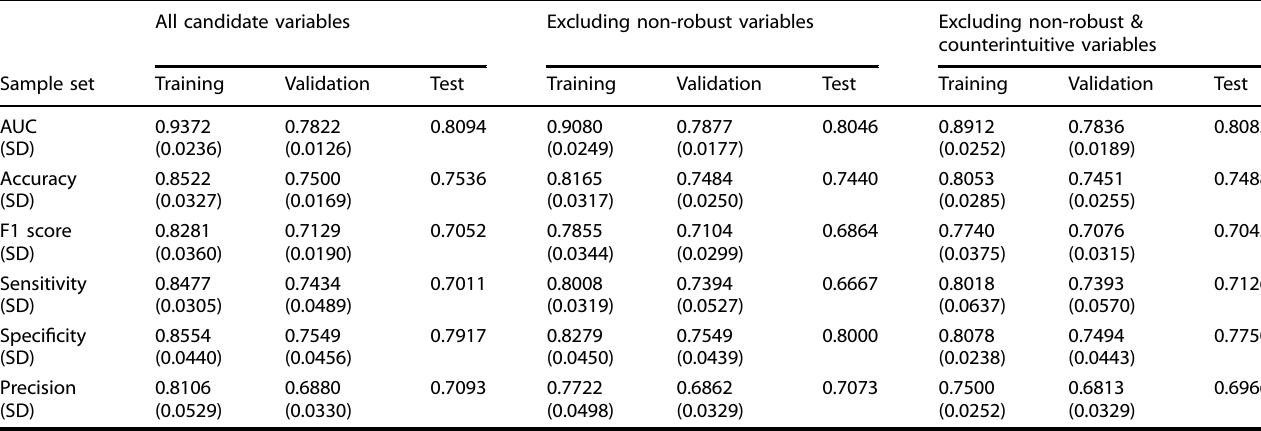
Table 2. Performance of the TBI prognostic model. All candidate